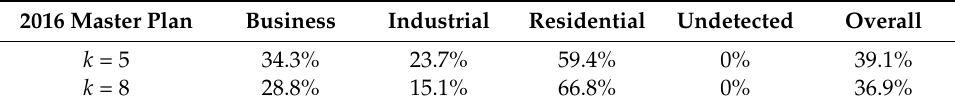
Table 3. The coverage ratio between 2016 Master Plan and cluster.